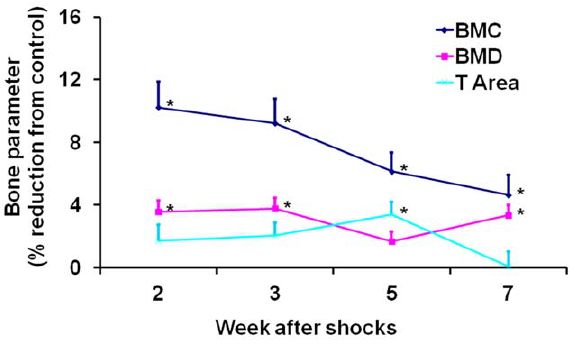
Figure 2. Reductions of bone mass parameters in total body in shocked mice. The shocked mice also include those injected with FG- 7142. For each parameter, values are means and S.E.M of percentage reductions compared to the control. An asterisk on the right indicates a significant difference from the control ( P , 0.05). doi:10.1371/journal.pone.0042684.g002 PLOS ONE |